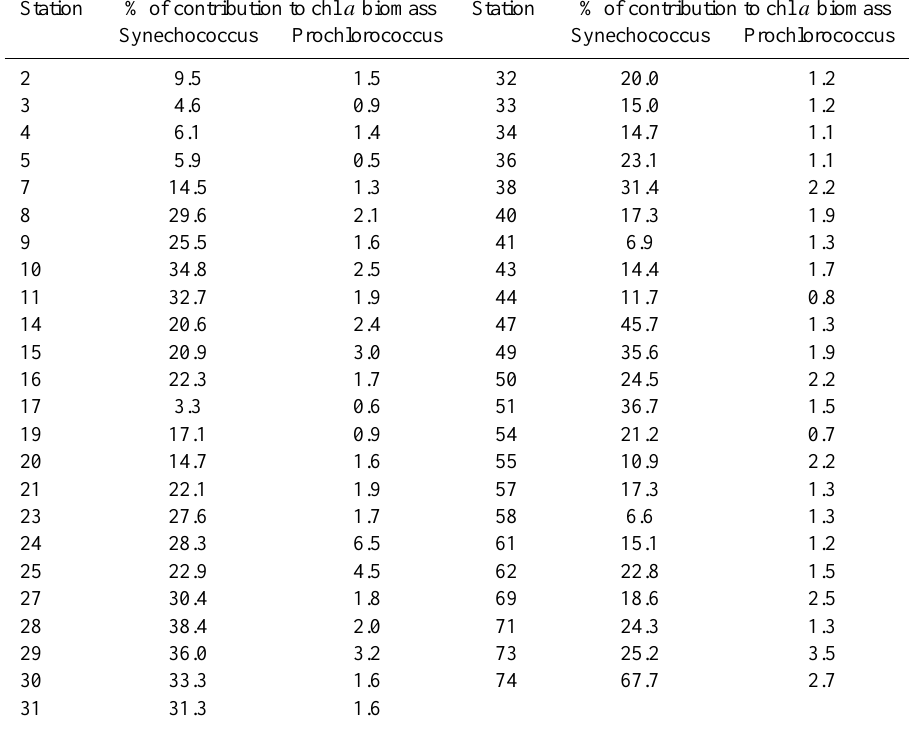
Table 3. Percentage of contribution of Synechococcus and Prochlorococcus to the overall chlorophyll a biomass. To calculate these contri- butions, chl a was expressed in terms of carbon biomass by using the ratio C/Chl a =50. Station % of contribution to chl a biomass Station % of contribution to chl a biomass Synechococcus Prochlorococcus